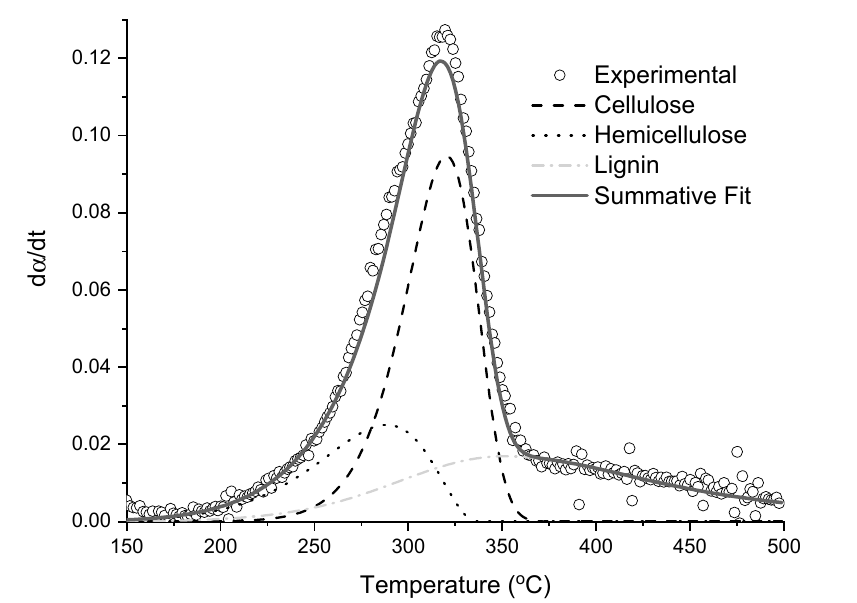
Figure 4. Example of curve-fitting using Arrhenius curves. Initial guess for each curve centered at the point devised by the DDTG method (see Table 5). WS-P, 10 K·min − 1 . The values for the isoconversional methods are displayed as graphs in Figure 5, and numeric values can be found in the SI. In Figure 5, one can see a visual range of conversion values for which apparent reaction energies for each lignocellulosic pseudo-component